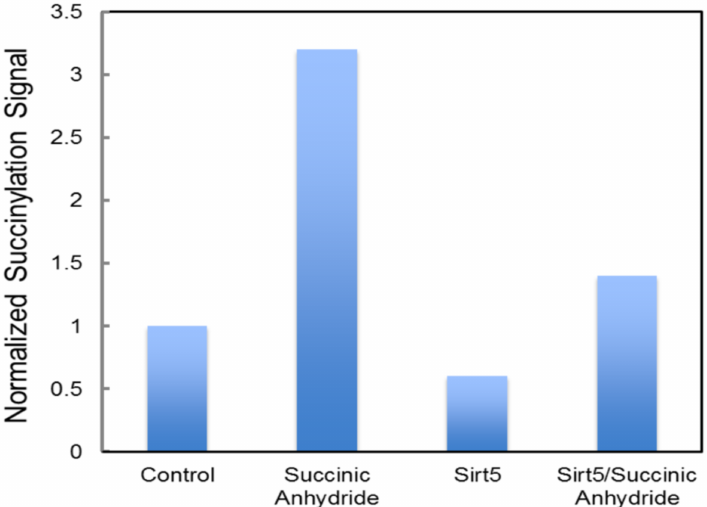
Figure 10. Desuccinylation of human FECH by SIRT5. Medlock and Dailey personal communica- tion. Recombinant FECH, ~100 µ M, was incubated with a 50-fold excess of succinic anhydride to succinylated FECH. Isolated, unsuccinylated FECH, and succinylated FECH samples were exposed to purified SIRT5. Quantitation of succinylation was via Western blot density analysis following SDS-PAGE. Anti-succinyl-lysine (PTM Biolabs) was used to detect succinylated protein. Proteins were purified as previously described [98].